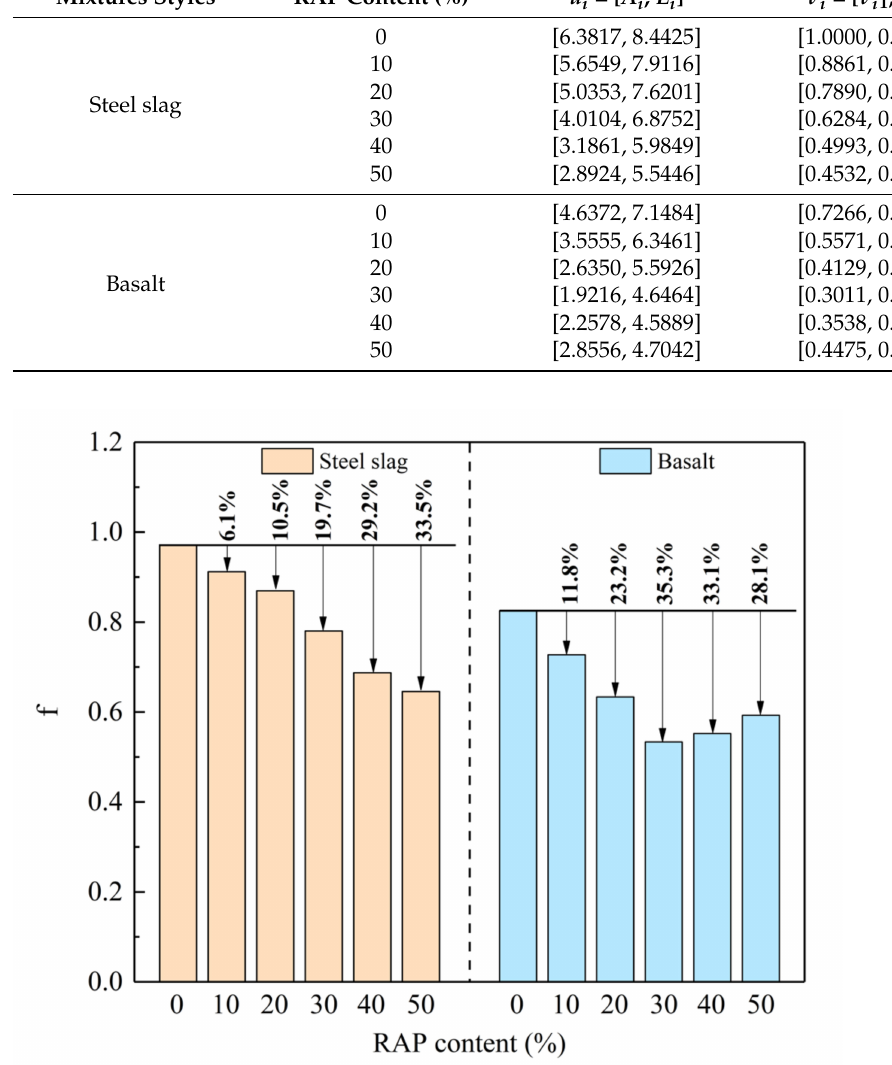
Figure 12. Comprehensive evaluation index of steel slag and basalt